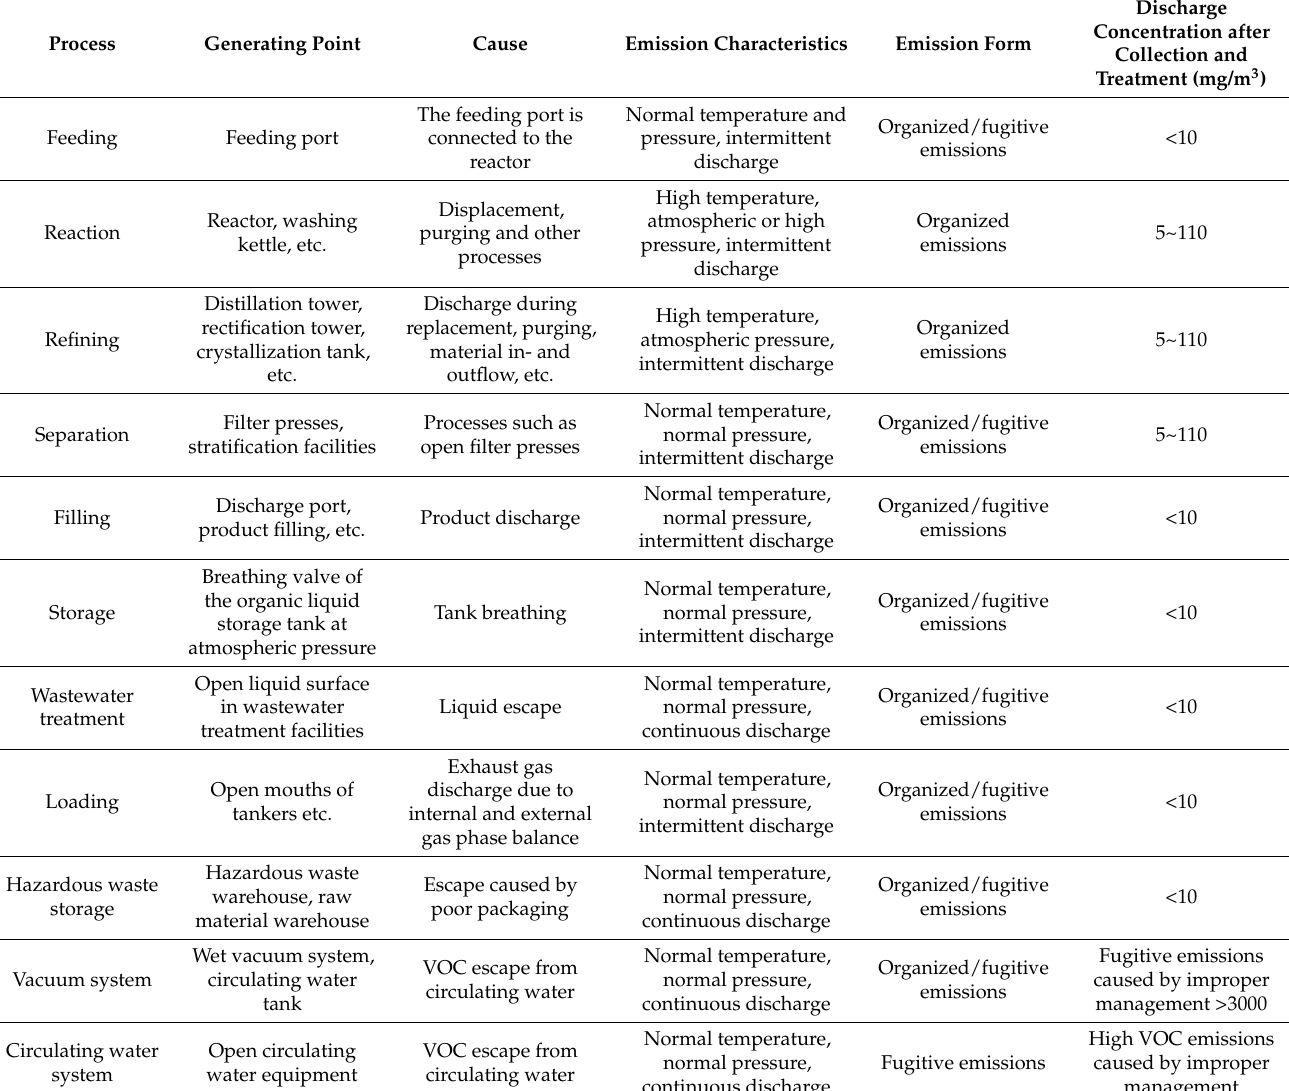
Table 2. Characteristics of VOC emissions in the pesticide